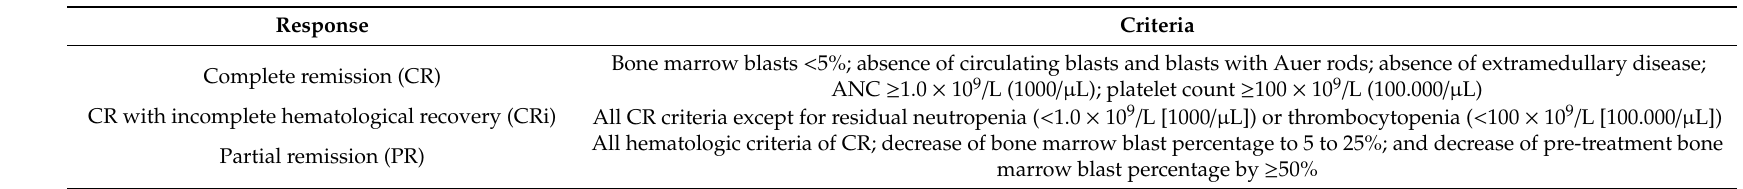
Table 3. Response criteria in